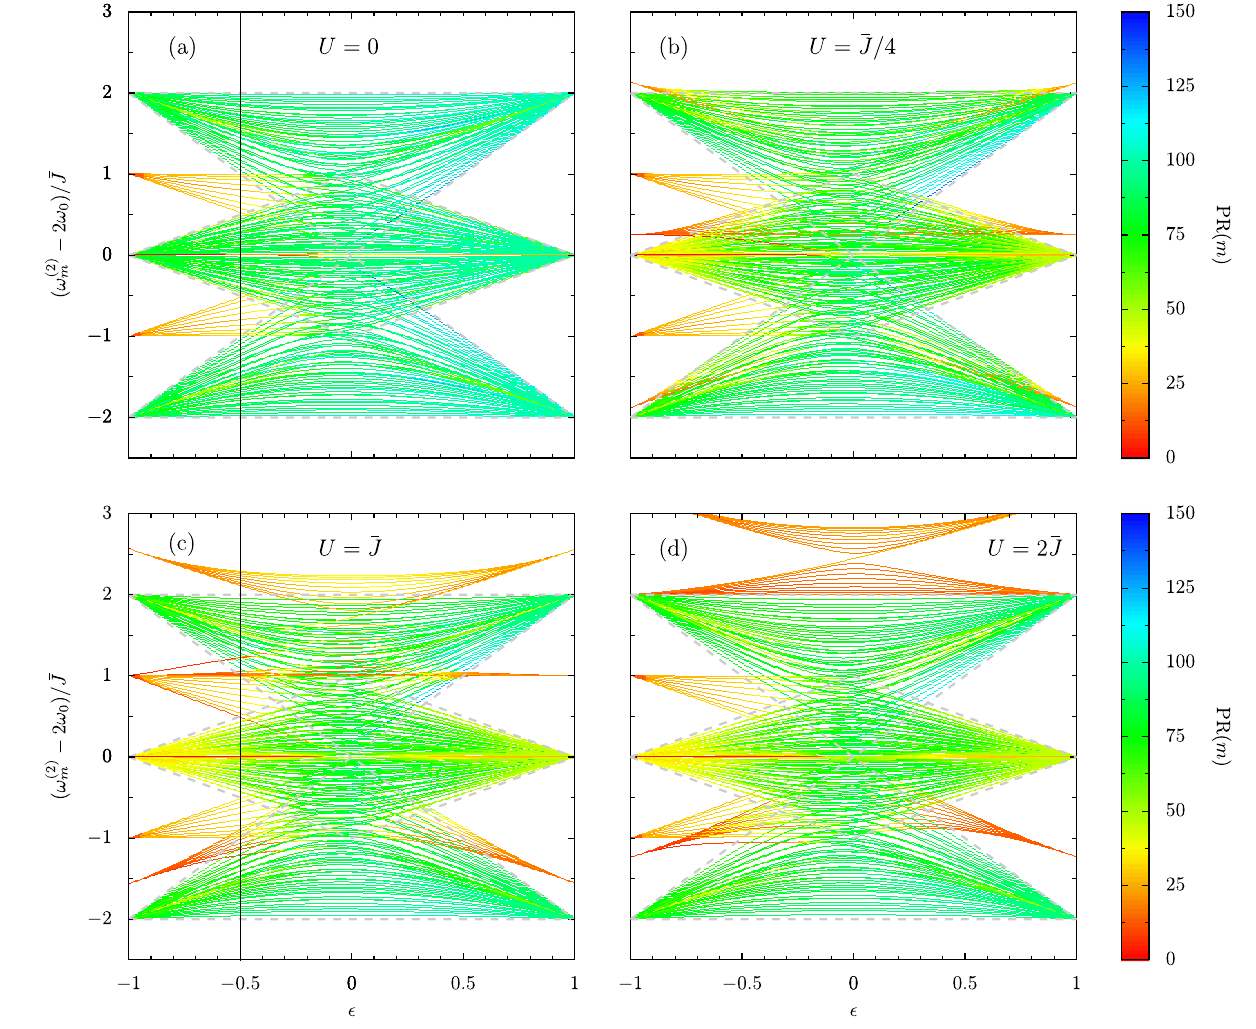
( 2 ) Figure 3. Eigenfrequencies ω m of a dimerized chain in the two excitation sector (as measured from 2 ω 0 , and in units of the coupling strength ¯ J ) as a function of the dimerization parameter ǫ [cf. Eq. (2)]. The interaction strength U increases upon going along the panels. Color bar: the participation ratio PR ( m ) of each state m . Highly localized states are red-orange in color, while extended state are blue-green. Dashed gray lines: regions enclosing the bulk scattering states, as calculated in the infinite chain limit . Solid gray vertical lines in panels (a) 1 / 2 , as guides for the eye. In the figure, the chain is composed of N and (c): cuts at ǫ = − to a 210-dimensional Hilbert